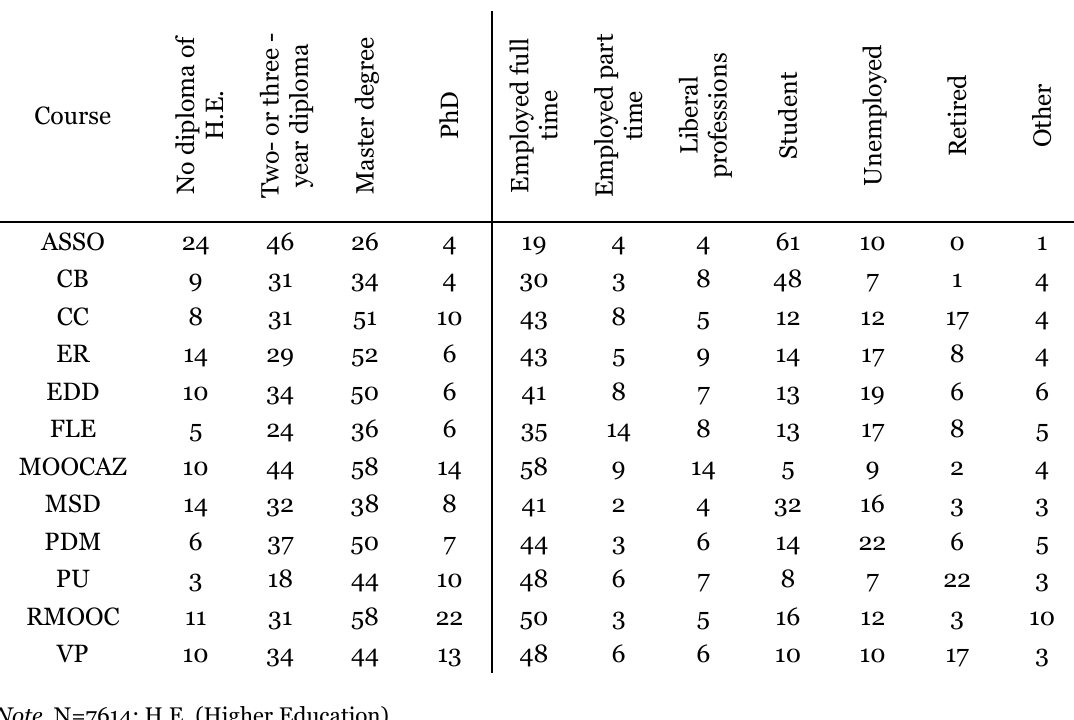
Sociodemographic Data of Studied